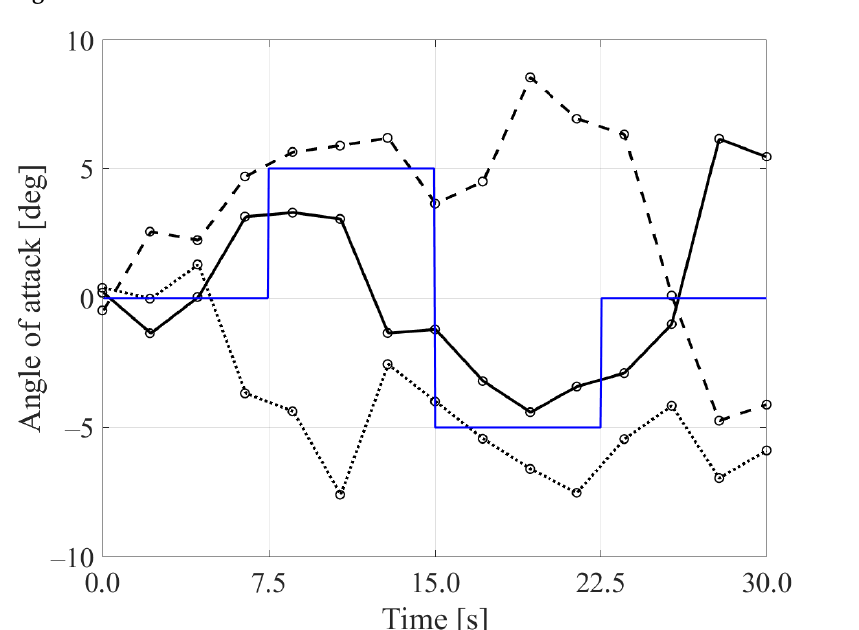
Figure 5. Examples of the angle-of-attack command schedules. Black lines show the schedules used in training with different random seeds. Blue line shows the doublet schedule used to evaluate the control